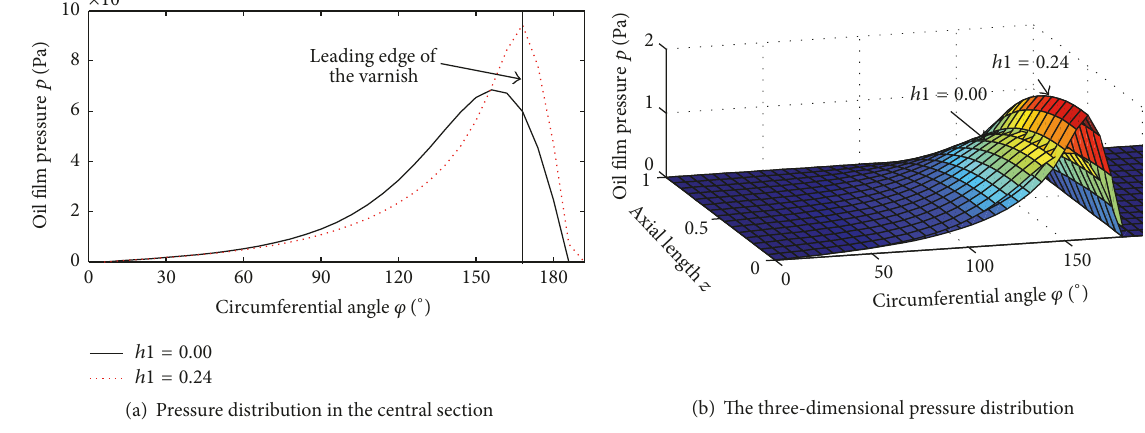
Figure 7: Oil film pressure distribution.